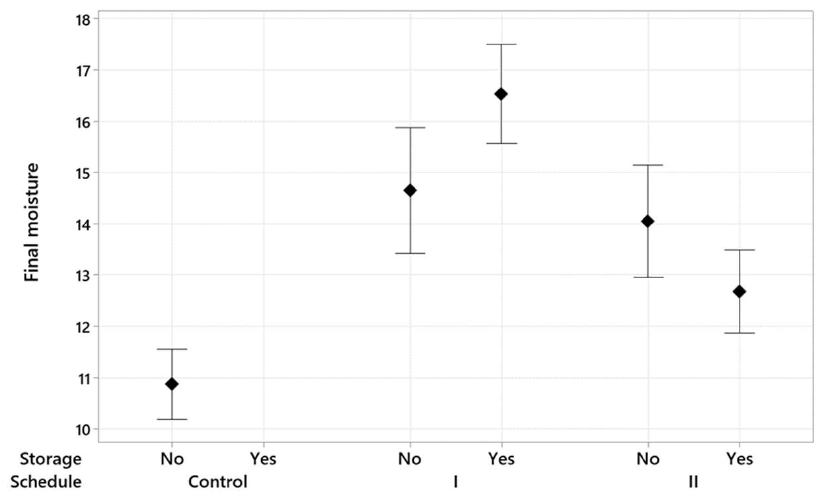
Figure 3. Interval plot of the M f for different drying schedules with the presence and absence of post-storge treatment. The results are at 95% of the confidence interval for the M f mean.